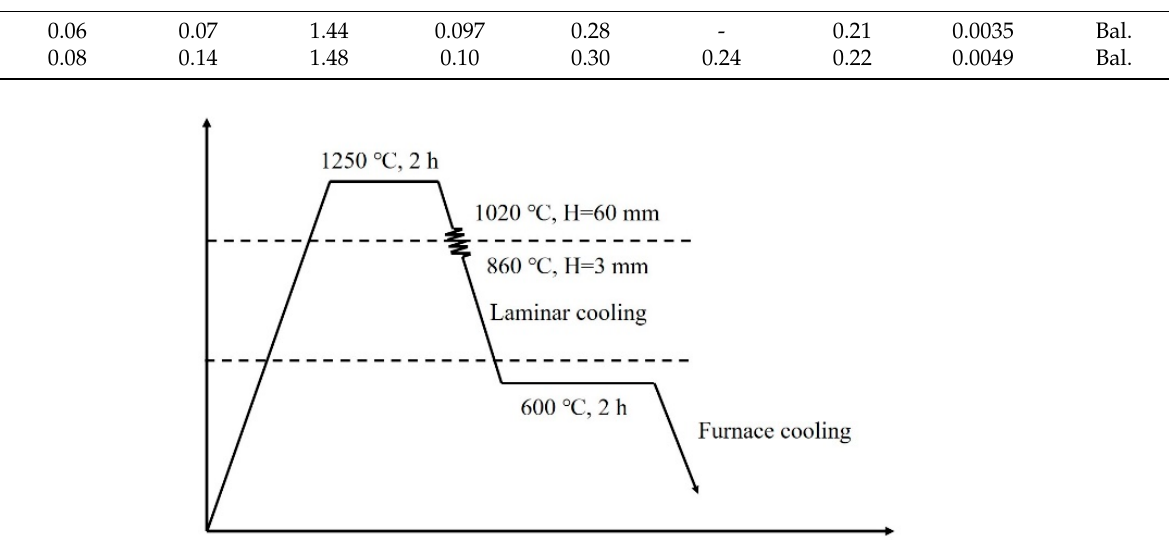
Figure 1. Schematic diagram of rolling process.